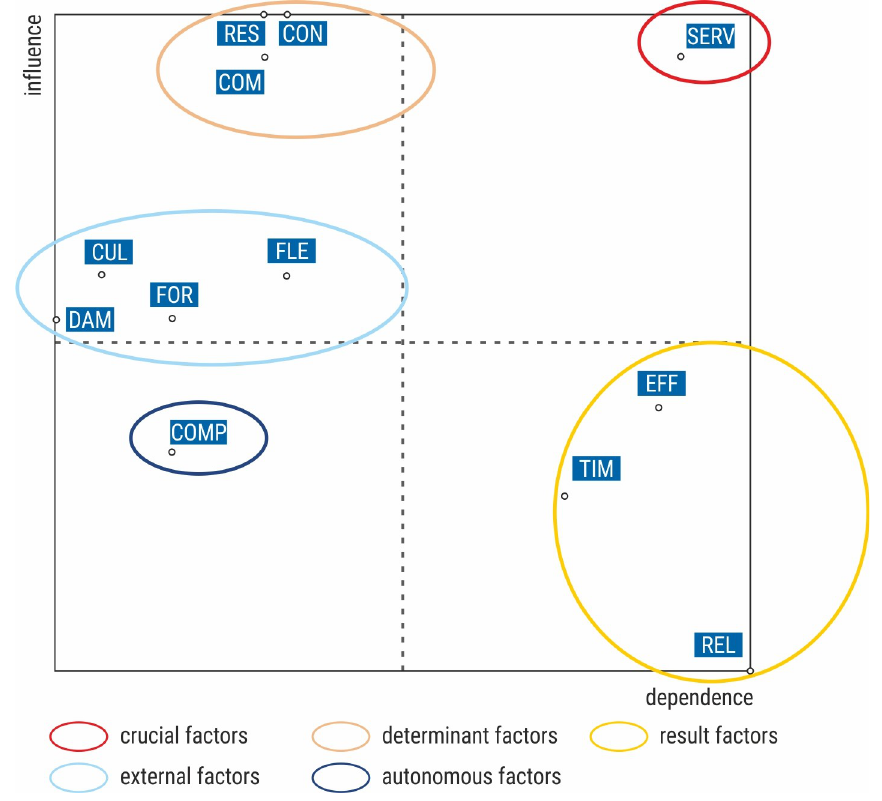
Fig 3. Influence–dependence graph. Source: Own